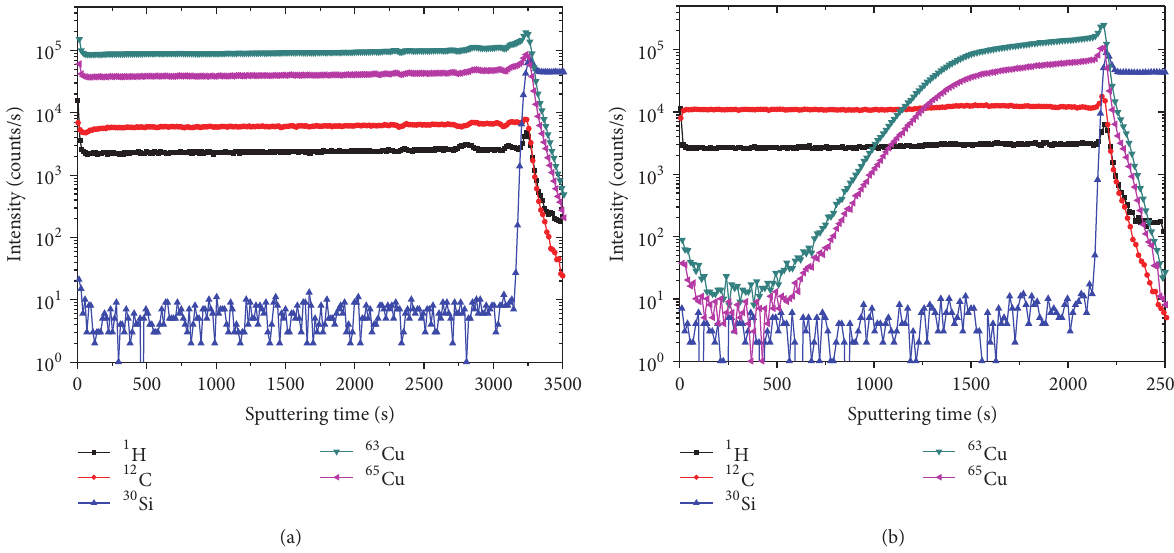
Figure 5: SIMS depth profiles of Cu-DLC films prepared by a flow of 20 sccm argon and different C 2 H 4 flow rates of (a) 2 sccm and (b) 6 sccm.